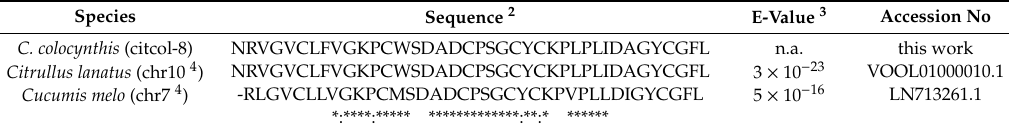
Figure 4. Homology and phylogenetic distribution of citcol peptides. ( A ) Maximum-likelihood phylogenetic tree calculated with sequences found by blastp searches against six-frame translated genomes / transcriptomes (E-value ≤ 0.1). The antimicrobial branch is colored in orange and the trypsin inhibitory branch is colored in black. The sequences are encoded by numbers (Data 2), and the Cucurbitaceae subfamilies summarized with one color (Cucurbita—green, Cucumis—light blue, Lu ff a—dark blue, Lagenaria—dark purple, Momordica—violet, Others—white). ( B ) Alignment of frequency logos calculated with citcol-1 to -8, sequences from the squash antimicrobial peptides branch and the squash trypsin inhibitor branch (see Materials and Methods for details). Cysteines are colored in yellow, amino acids with positively charged side chains (at pH 7) are colored in blue (H, K, R) and with negative charged sidechains (at pH 7) are colored in red (D, E). Gaps ‘-’ were introduced to maximize the alignment. Table 2. Homologous sequences of citcol peptides found by a tblastn search against Genbank 1